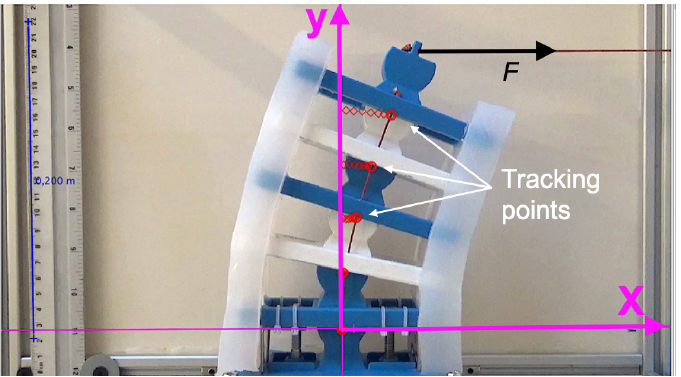
Figure 11. Image tracking of musculoskeletal system motion was obtained using an app called Tracking. The ruler on the left side was utilized for scaling the experimental